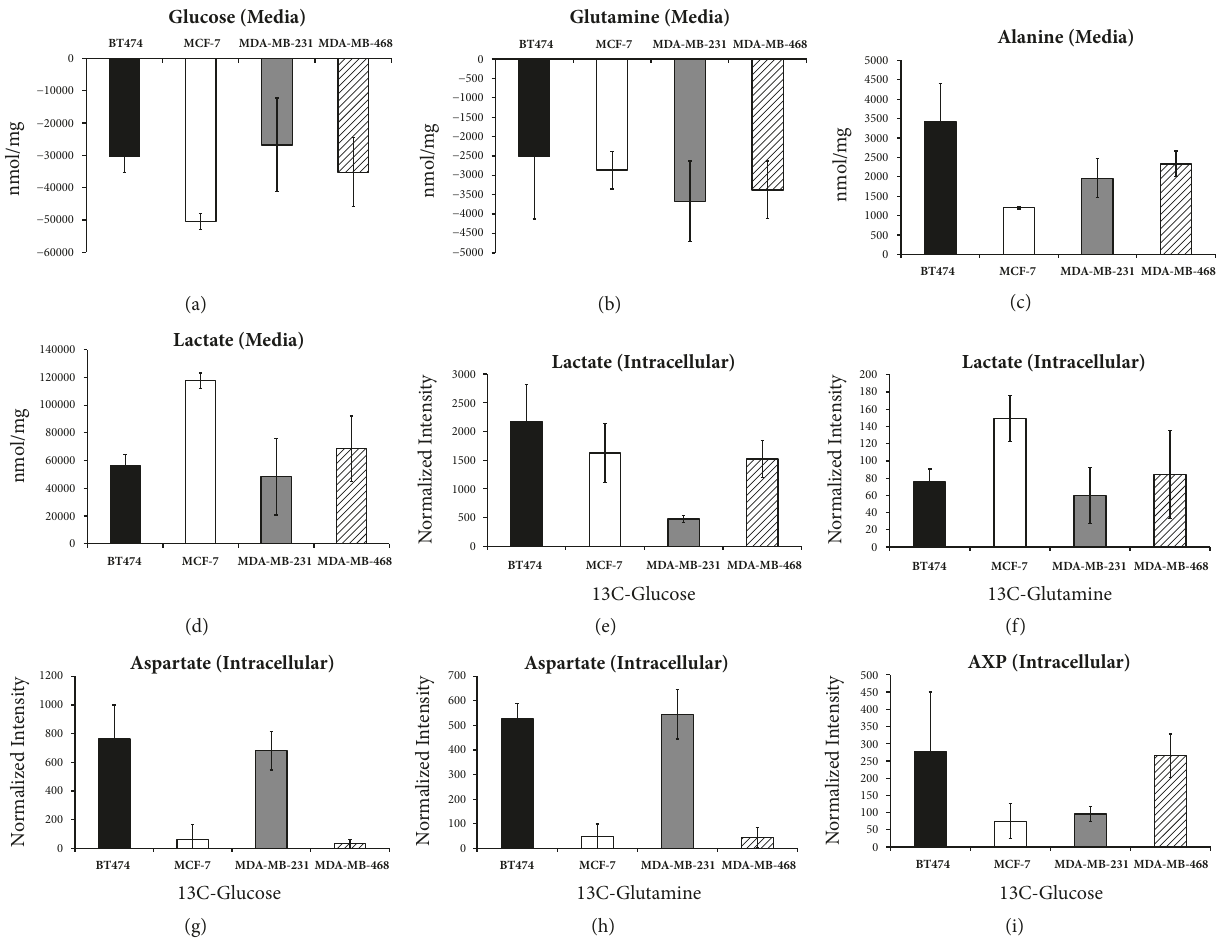
Figure 1: Intracellular and media levels for selected metabolites of interest. Glucose and glutamine values indicate media consumption. AXP is the sum of AMP, ADP, and ATP whichhave overlapping peaks thatare difficult to differentiatein this case. Graphs are presented as averages of three replicate measurements for each condition/cell line with the error bars reflecting standard deviation between